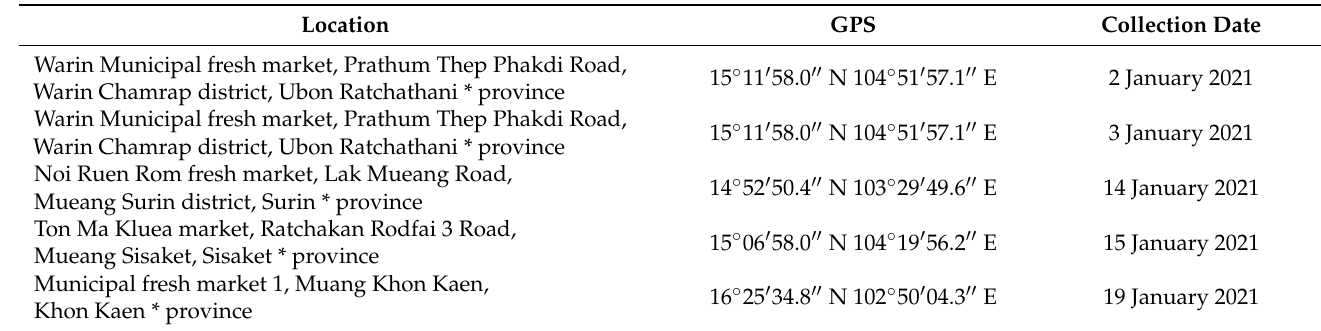
Table 1. Sources for yeast